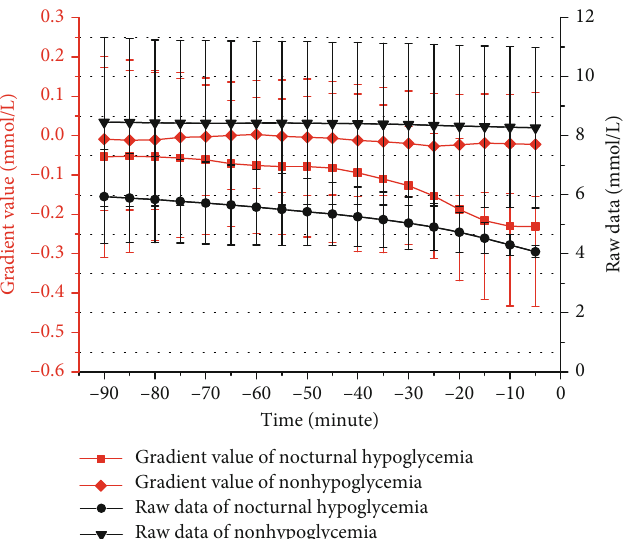
Figure 1: Raw data and gradient value from t = − 90minutes to t = − 5 minutes before the nocturnal hypoglycemic events occurred at t = 0 minutes . The results in Figure 1 were presented as mean ± standard